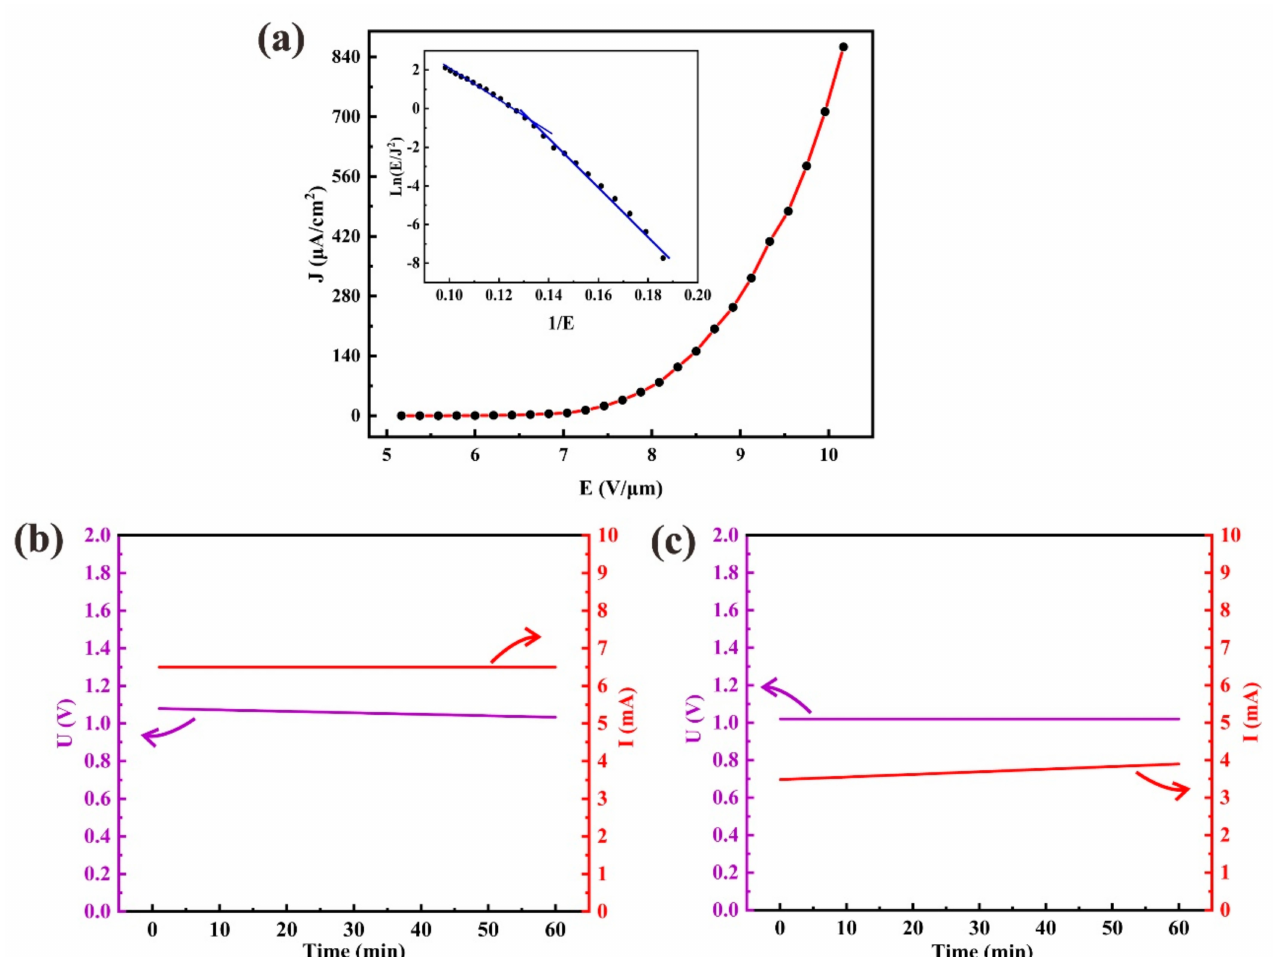
Figure 6. ( a ) Field emission curve (J-E) and Fowler-Nordheim (F-N) plot (inset) of ZnO nanowires with indium doping ( b , c ) Field emission stability of ( b ) voltage (U) with constant current at 6.5 mA and ( c ) direct current (I) with constant voltage of 1.02